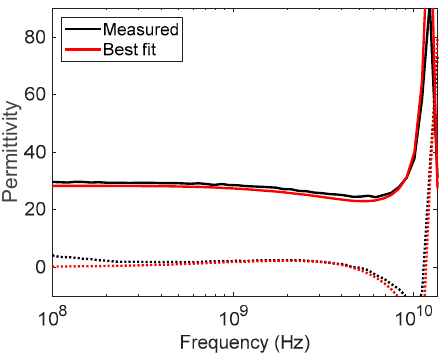
Figure 9. Measured permittivity of a hydrate layer backed by gas and best fit from COMSOL Multiphysics simulations.